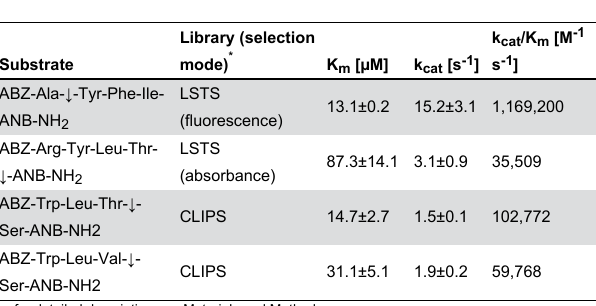
Table 3. Kinetics of hydrolysis of SplD